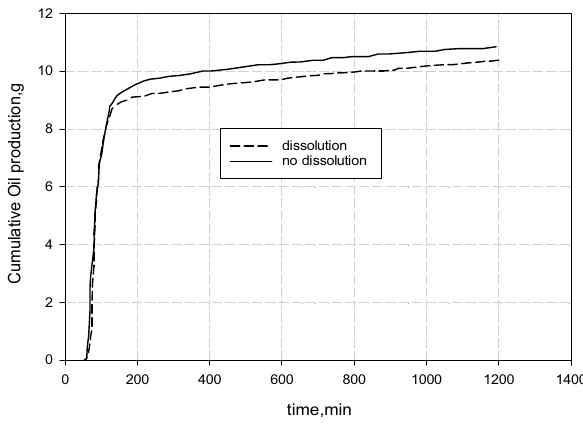
Fig. 15 Oil production rate curve contrasting dissolution and no dis- solution (experiment 2) 2 pressure-recov-